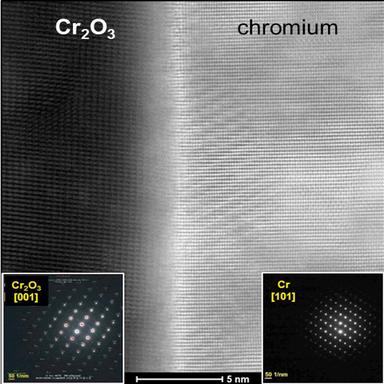
STEM-HAADF image of the scale/metal interface in the area marked using rectangle "3" in A; Insets: SAED patterns recorded for the oxide and the metal.